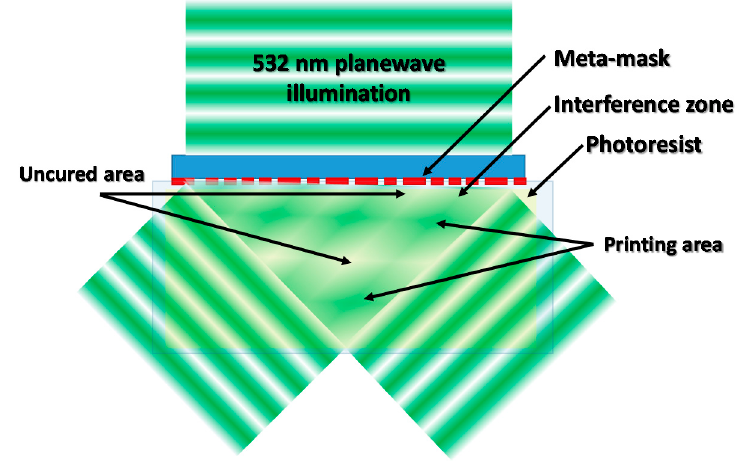
Figure 10. Creation of diffraction pattern by meta-mask setup involved in 3D printing process.